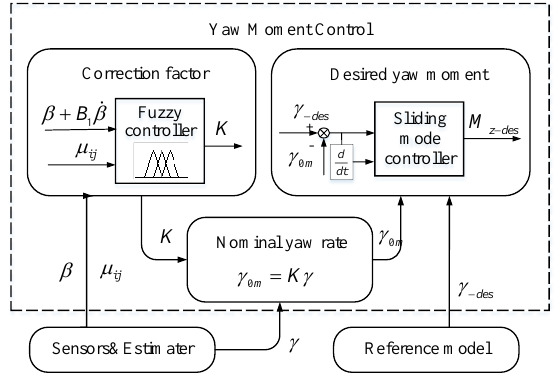
Figure 4. Structure of the yaw moment control.